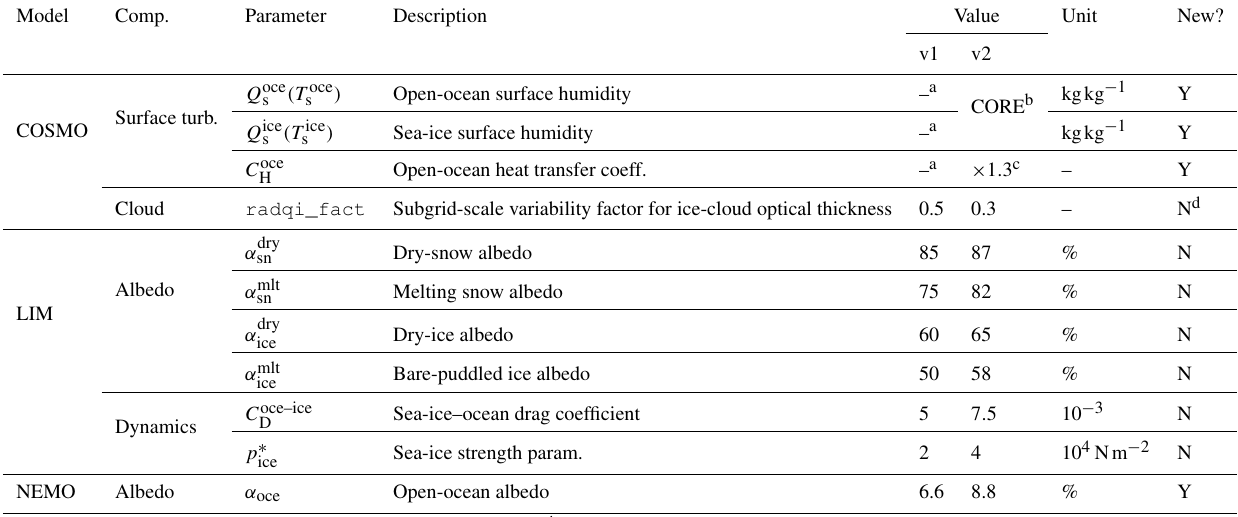
Table E1. Details on PARASO tunings. For each parameter, one of two values or methods is given: v1 (raw, non-tuned) or v2 (tuned). The “New?” column specifies whether this tuning parameter was introduced for PARASO (Y) or already existed in the model (N). Model Comp.